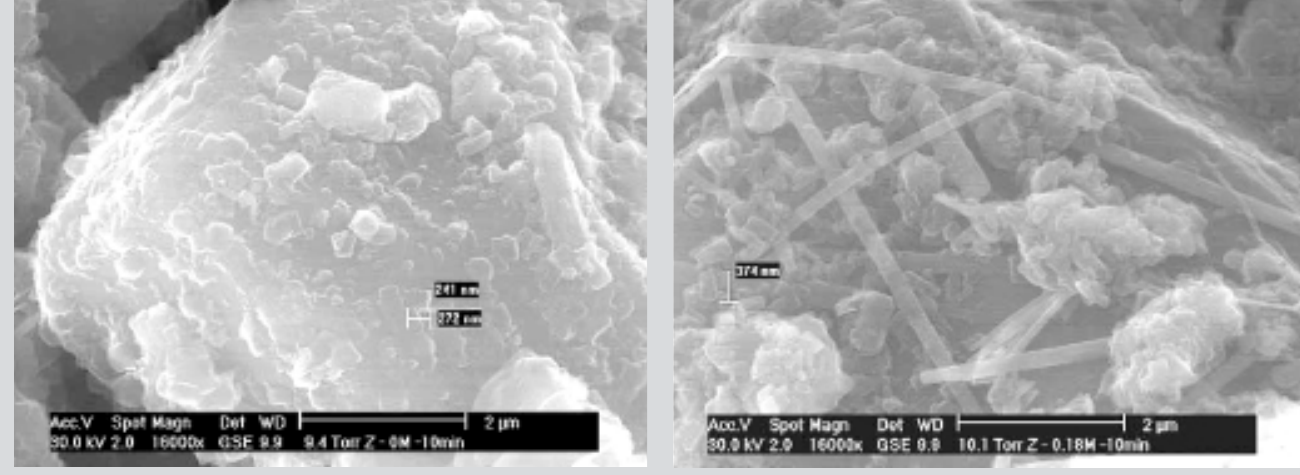
Figure 2: Reference specimen (left) and 0.18% K 2 SO 4